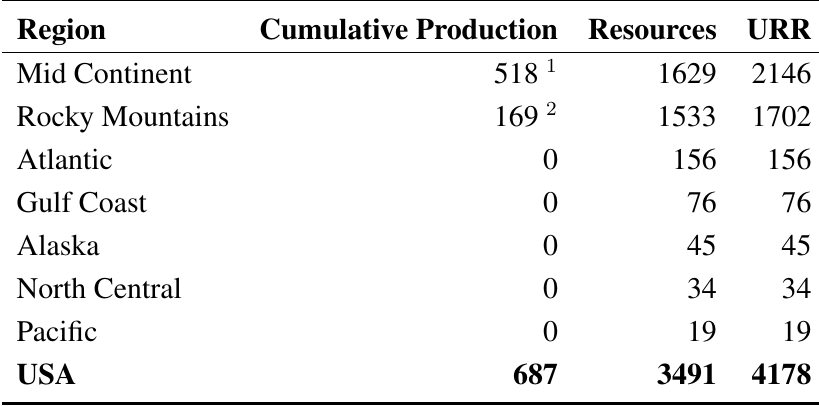
The cumulative production, resources (from [30]) and ultimately recoverable resources (URR) of helium in the USA by region (kilotonnes of He). Region Cumulative